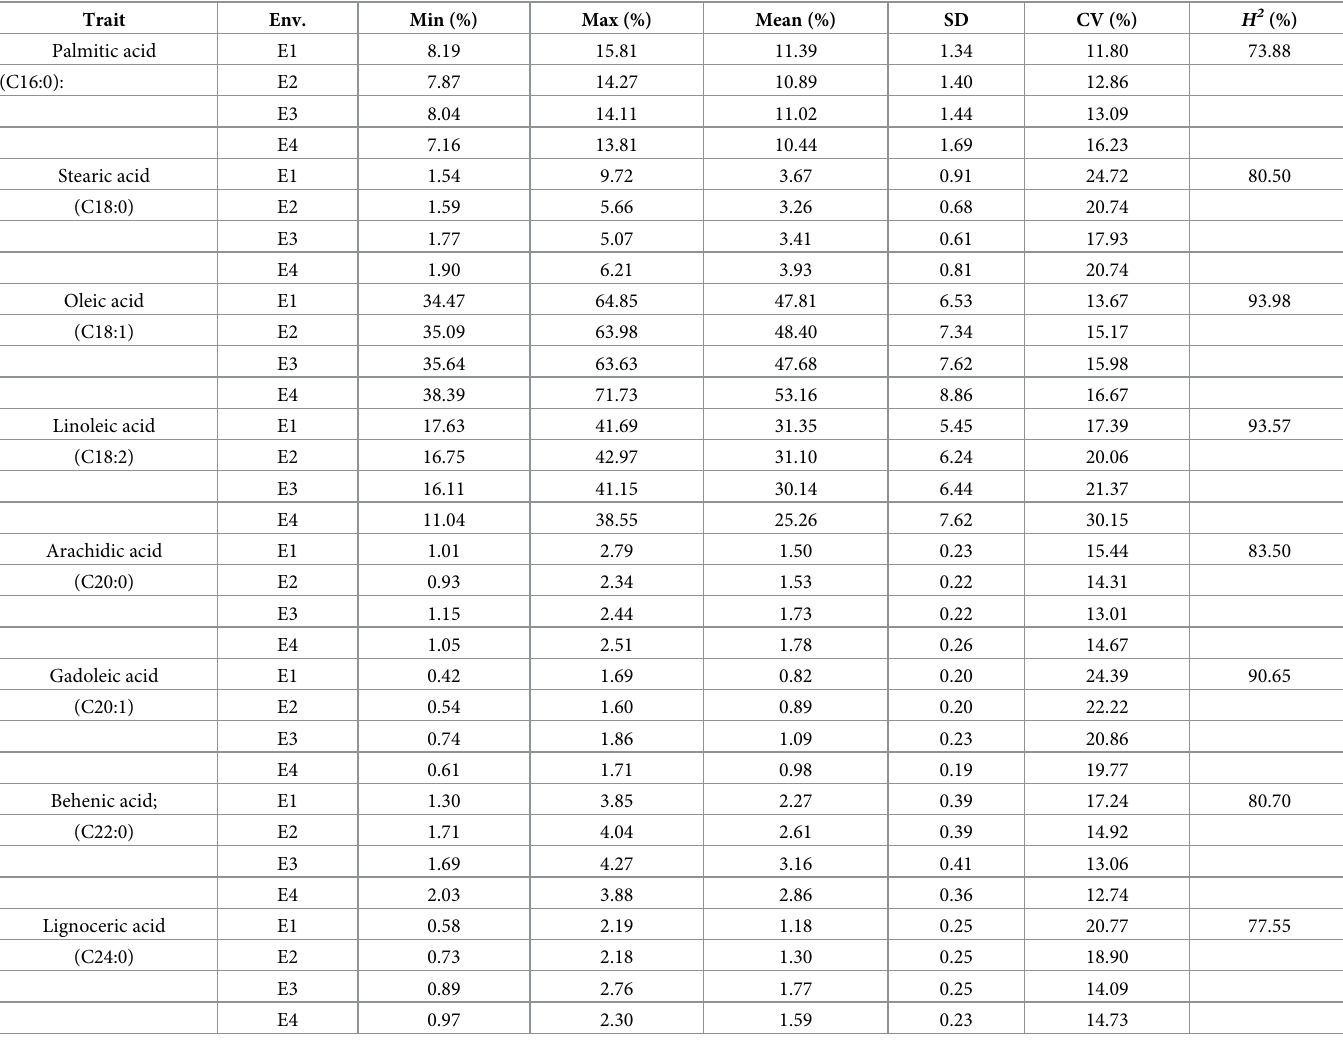
Table 1. Description of phenotypic analysis for the fatty acid traits in the association population under multi-environments. Trait Env.